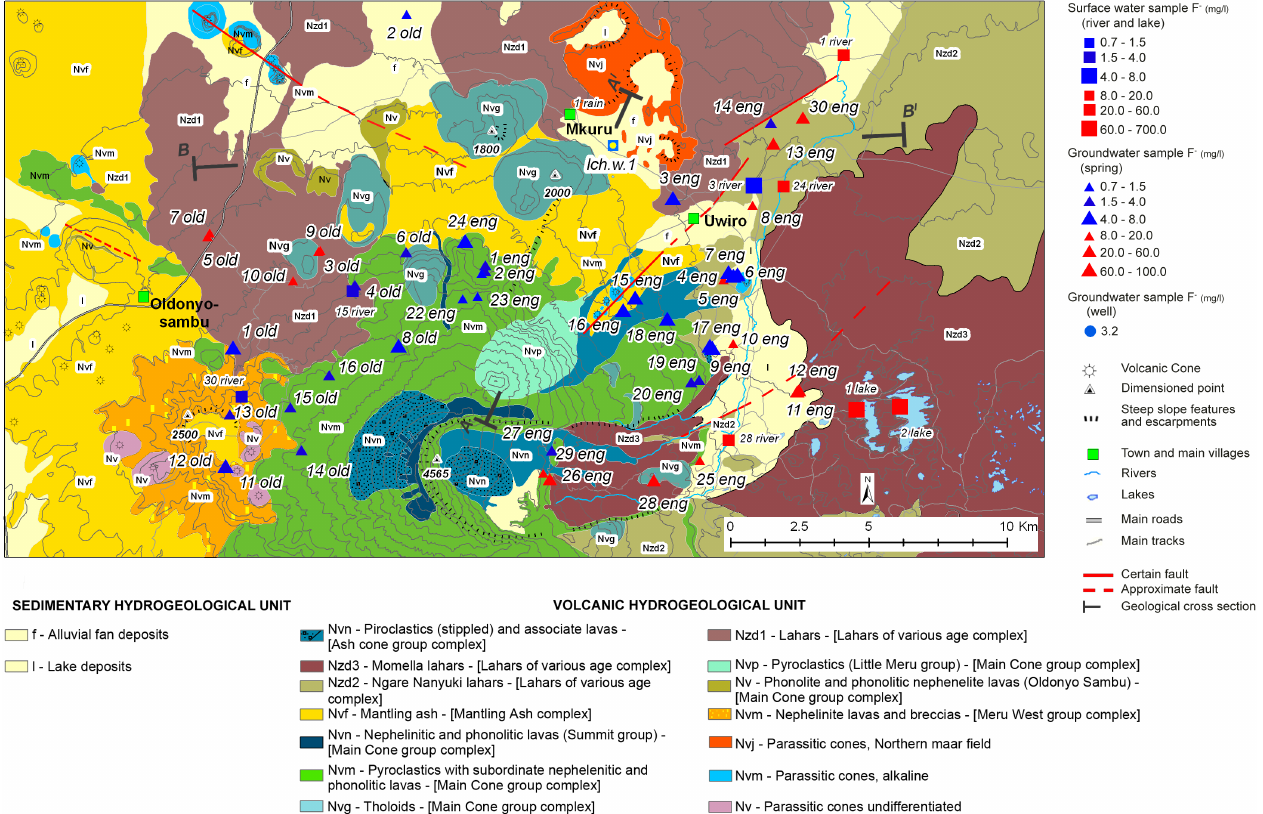
Fig. 2. Geological-hydrogeological map of the study area, indicating the location of water